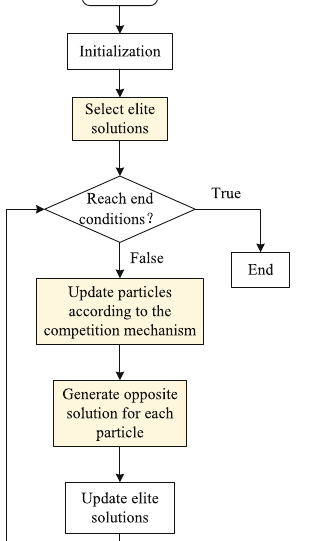
Fig. 5 The flowchart of D 2